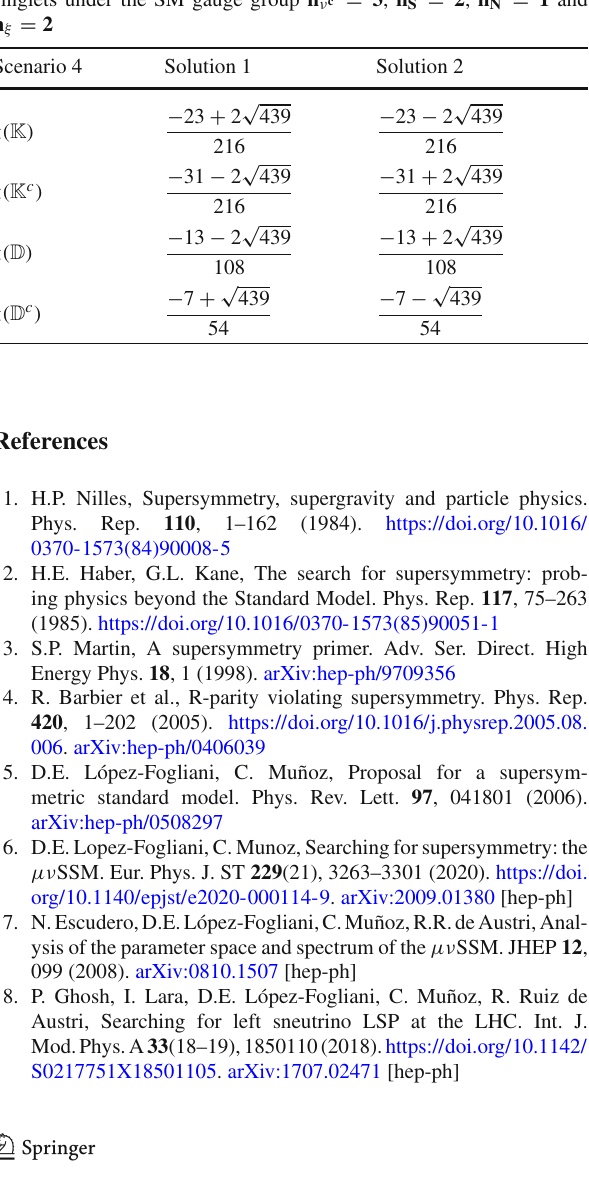
Table 32 The same as in Table 31, but with the minimal number of singlets under the SM gauge group n ν c = 3 , n S = 2 , n N = 1